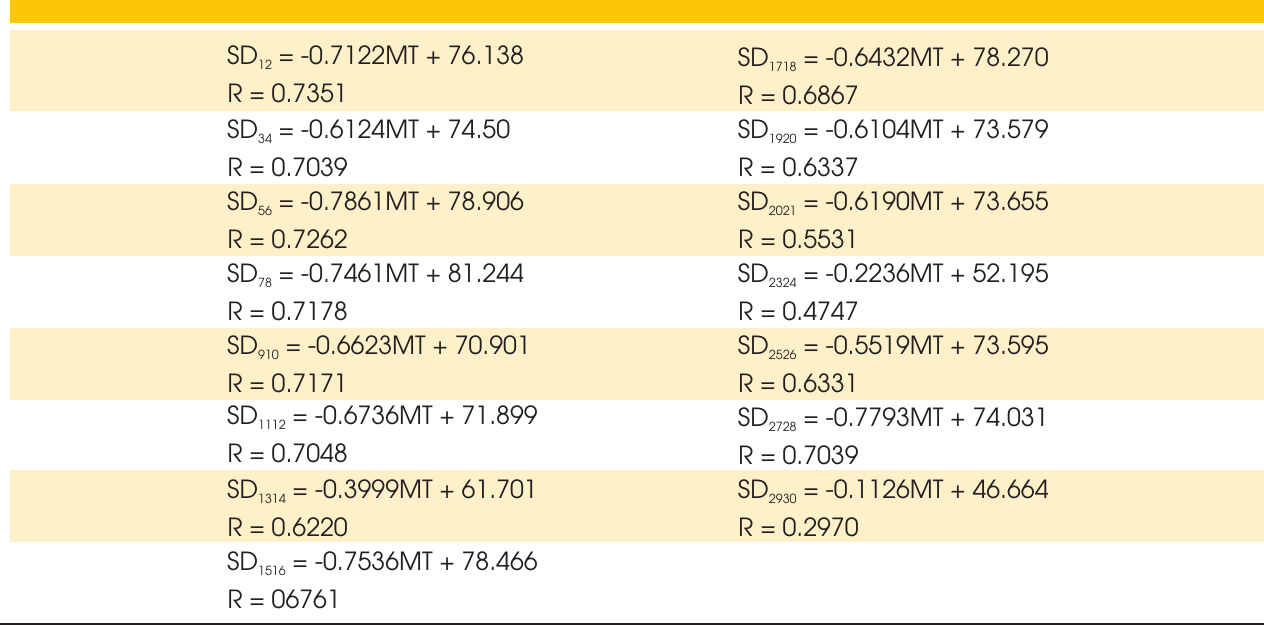
Table 7 – Models obtained by simple linear